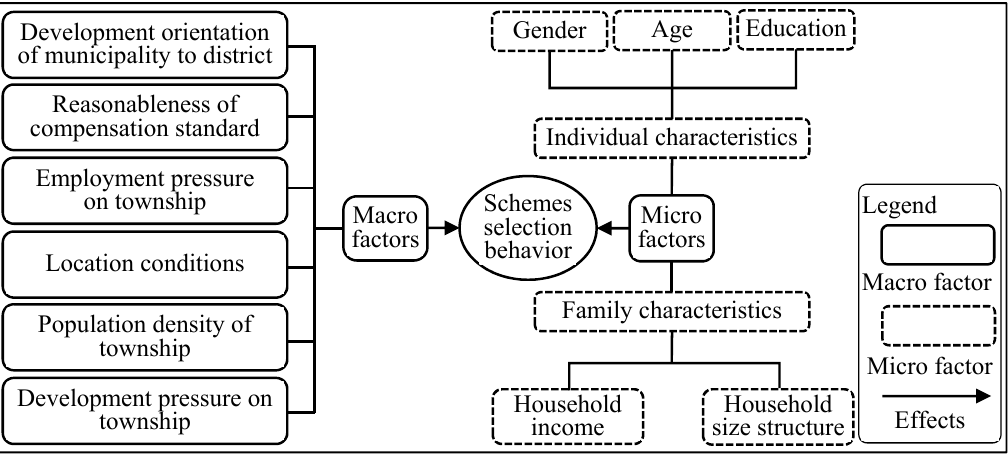
Figure 3. The theoretical analysis framework of this paper. Table 2. A generalized presentation of the research